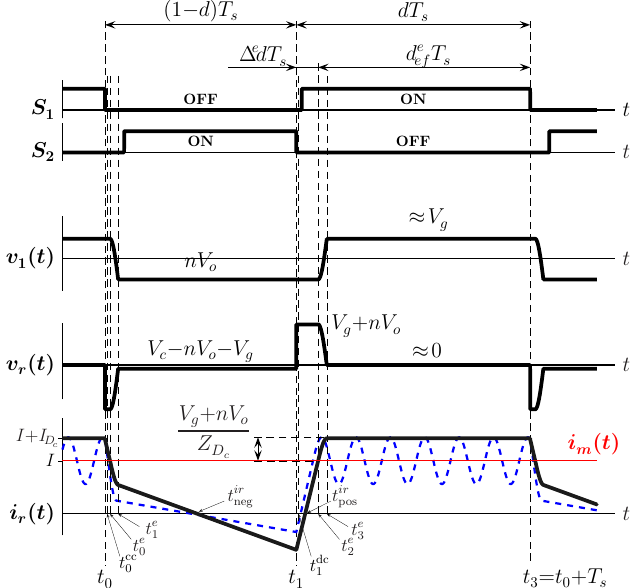
Figure 7. Main theoretical waveforms of the EACF topology. The resonant current i r ( t ) is plotted for the enhanced topology by the solid line and for the ACF with parasitics by the dashed